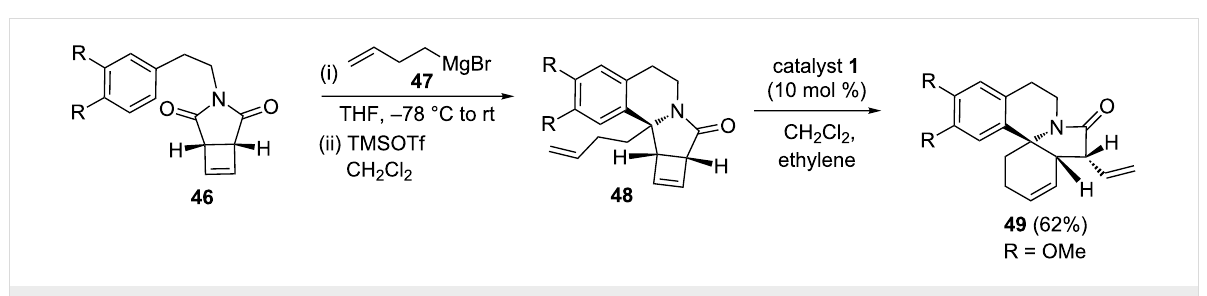
Scheme 7: RRM approach to erythrina alkaloid